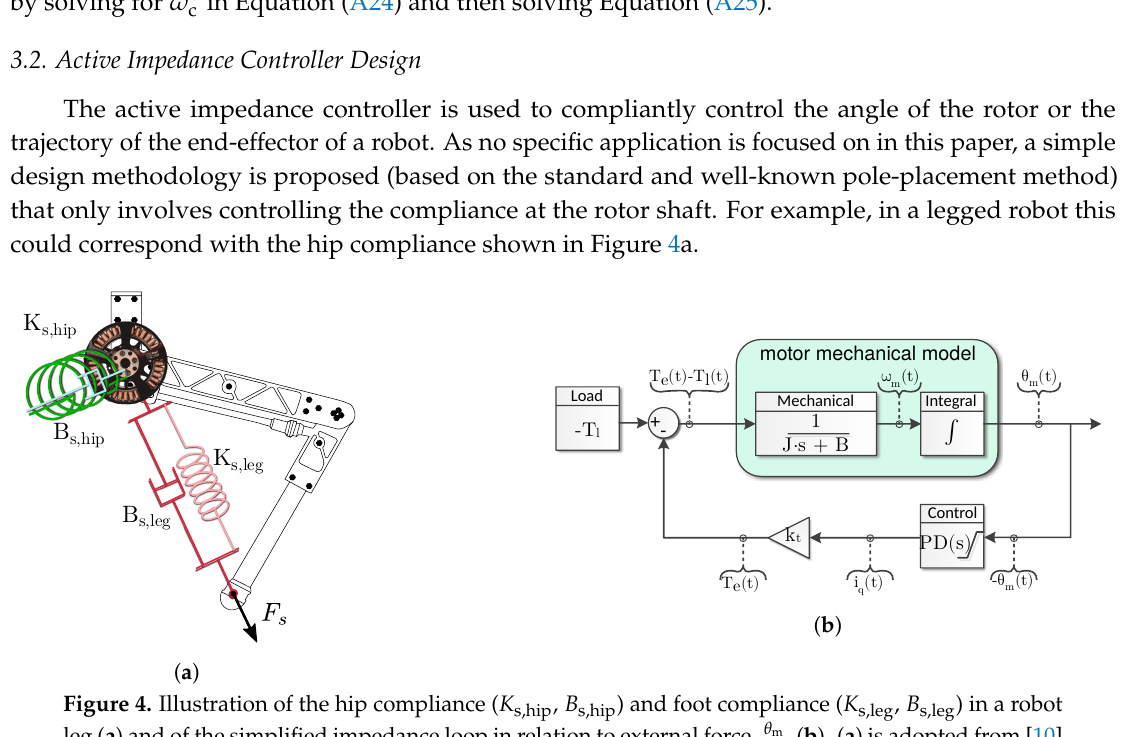
( b ). ( a ) is adopted from [10] T l